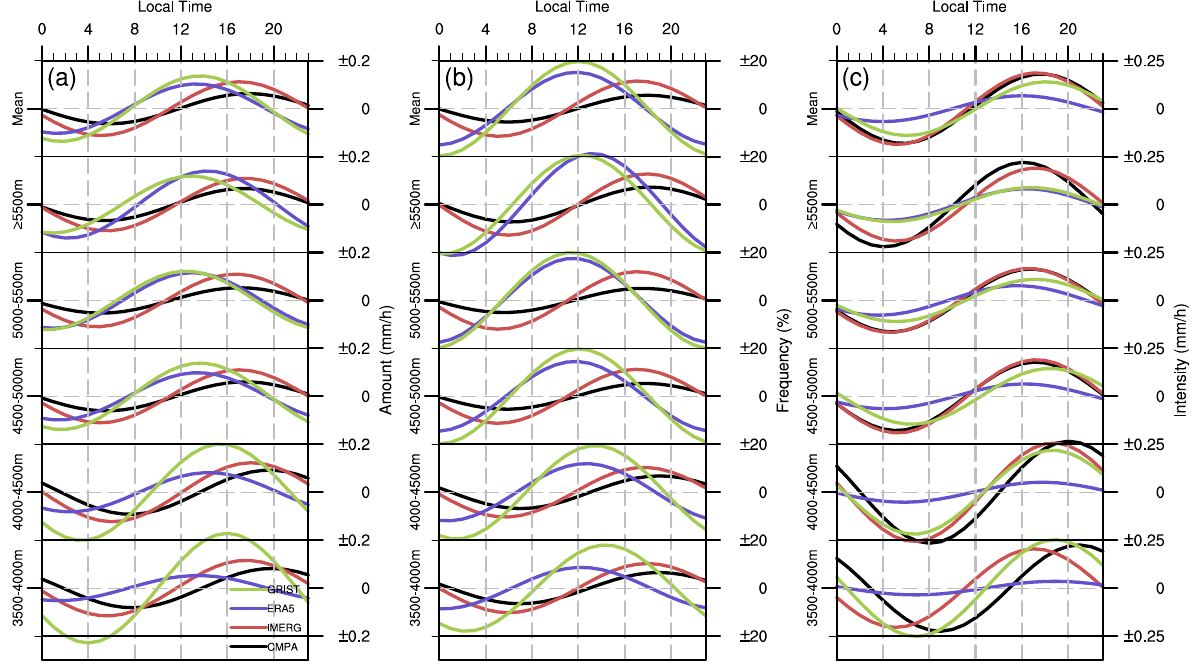
Figure 8. Elevation dependence of the diurnal harmonic of precipitation variables (( a ) amount (mm/h); ( b ) frequency (%); ( c ) intensity (mm/h)) in YTRV. Horizontal solid black lines separate different altitude blocks, and the horizontal dashed gray line in the center of each block marks the zero line. The altitude of each block increases from bottom to top, with the mean diurnal harmonic of YTRV displayed in the block at the top. The labels on the right Y -axis represent the values of the diurnal harmonic curve, with positive (negative) values above (below) the zero line (negative). The labels on the left Y -axis indicate the altitude intervals represented by each subgraph. The X -axis indicates the hour (local time) of the 24-h rainfall cycle. Black stands in for the CMPA dataset, red for IMERG, violet for ERA5, and green for